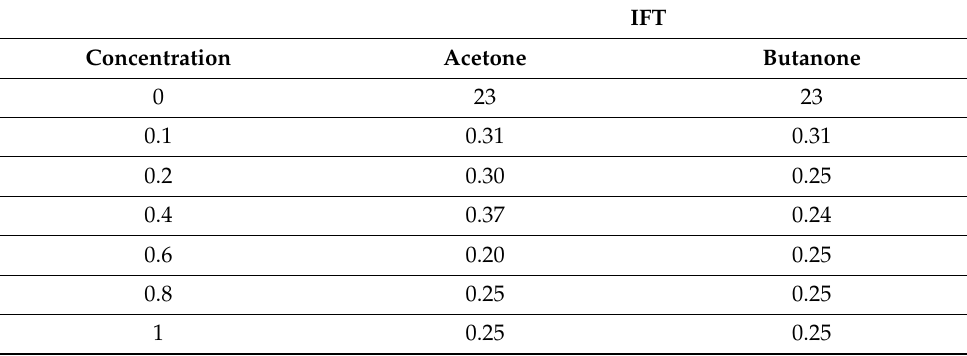
Table 7. IFT Comparison for the Two Formulations.